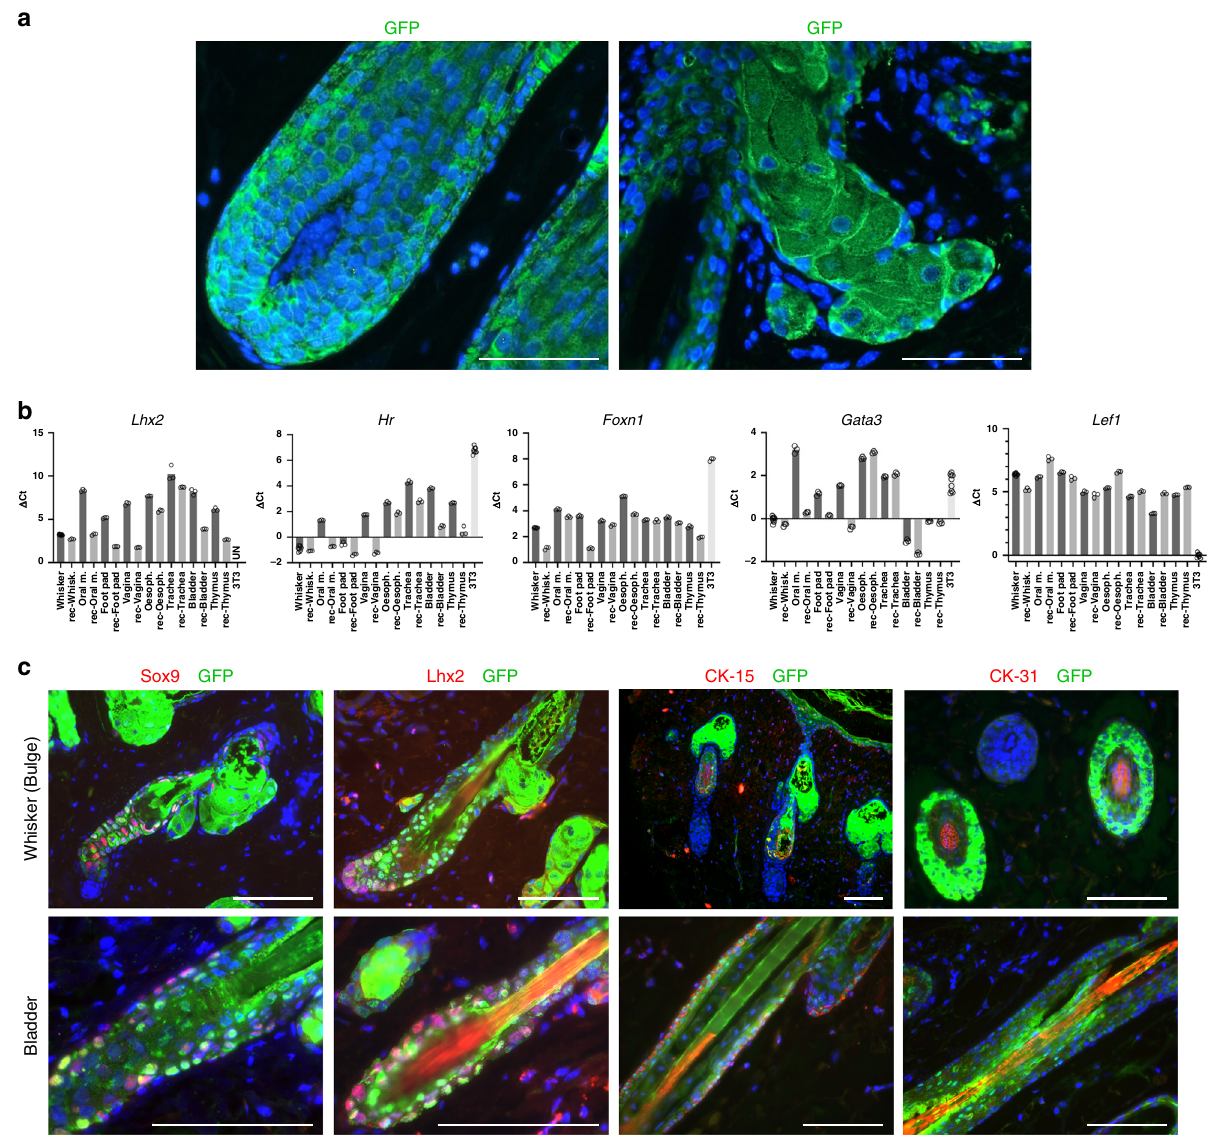
Fig. 2 Expression of hair follicle lineage markers by transplanted bladder epithelial cells. a Microscopic appearance of a hair follicle bulb (left) and of a sebaceous gland (right) generated by epithelial cells cultured from the bladder of an EGFP rat and transplanted into a newborn mouse skin microenvironment (103 and 238 days after transplantation, respectively), n = 3 mice. EGFP expression (green) was revealed by immunohistochemistry, nuclei (blue) were counterstained with Hoechst 33342. Note that the transplanted EGFP cells contributed to all the differentiated lineages of the hair follicle and sebaceous glands; bars: 100 μ m. b Expression of several transcription factors important for hair follicle differentiation as determined by qPCR analysis. Δ Ct results were normalized against housekeeping genes ( TBP , SDHA, and Tubb ). Mean of 3 – 9 technical replicates with individual data represented by empty circles. c Transplanted EGFP-positive bladder epithelial cells expressed SOX9, LHX2, cytokeratin-15 (CK-15), and cytokeratin-31 (CK-31) at the proper location in the hair follicles. For each marker, n = 3 experiments. Hair follicles and sebaceous glands generated from multipotent epithelial stem cells cultured from a whisker follicle were used as control. SOX9 (red): whisker: day 103 after transplantation, bladder: day 103; LHX2 (red): whisker: day 238, bladder: day 236; CK-15 (red): whisker: day 103, bladder: day 238; CK-31 (red): whisker: day 236, bladder: day 103. EGFP expression (green) was revealed by immunohistochemistry, nuclei (blue) were counterstained with Hoechst 33342. Bars: 100 μ